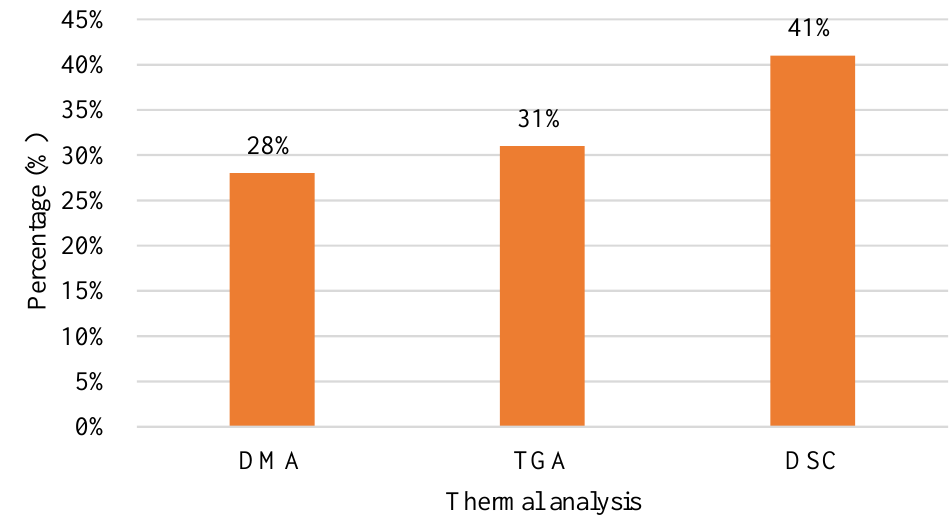
Figure 14. Thermal analysis of FDM polymer composite from the year 2011 to 2021. Table 4. Comparison of TGA and DSC.